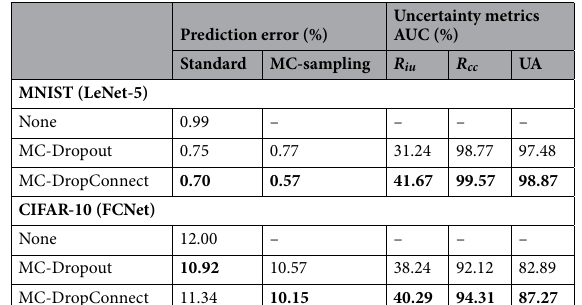
Table 1. Test prediction error (%) and uncertainty estimation performance of the LeNet and FCNet networks and their Bayesian estimates on the MNIST and CIFAR-10 datasets. The models with the best performances are shown in